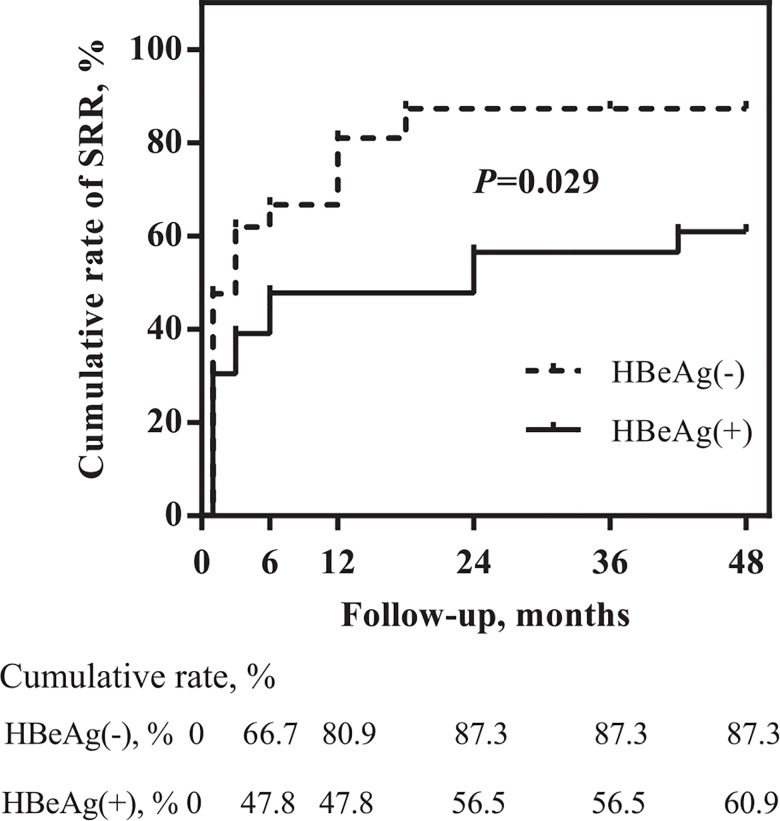
Cumulative rate of SRR achievement in patients with ETV therapy by HBeAg status at baseline.SRR (sustained response rate) was defined as HBV DNA <20 IU/mL, loss of HBeAg and normalization of ALT activity (<40 IU/L) in patients HBeAg(+) or as undetectable HBV DNA <20 IU/mL with normalization of ALT activity in HBeAg(-) patients.